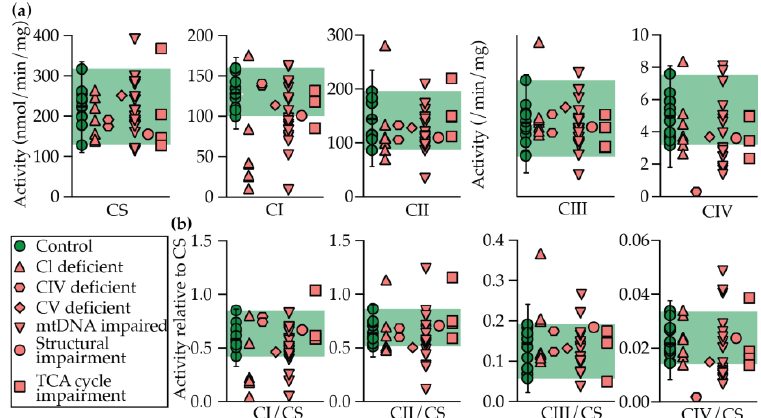
Figure 2. Enzymology in control and PMD patient fibroblast cell lines. Control and PMD patient fibroblasts were measured CS and respiratory chain complex I–IV (CI–IV) activity by spectrophotometric methods. Results are presented as either ( a ) raw rates, or ( b ) relative to CS activity. Median is displayed for controls with error bars showing the 1.25th and 98.75th percentiles of the reference range, and the green shading region shows the range. Each data point represents the average of each patient or control from ≥ 2 technical replicates Abbreviations: CI–IV, respiratory chain complexes I–IV; CS, citrate synthase.